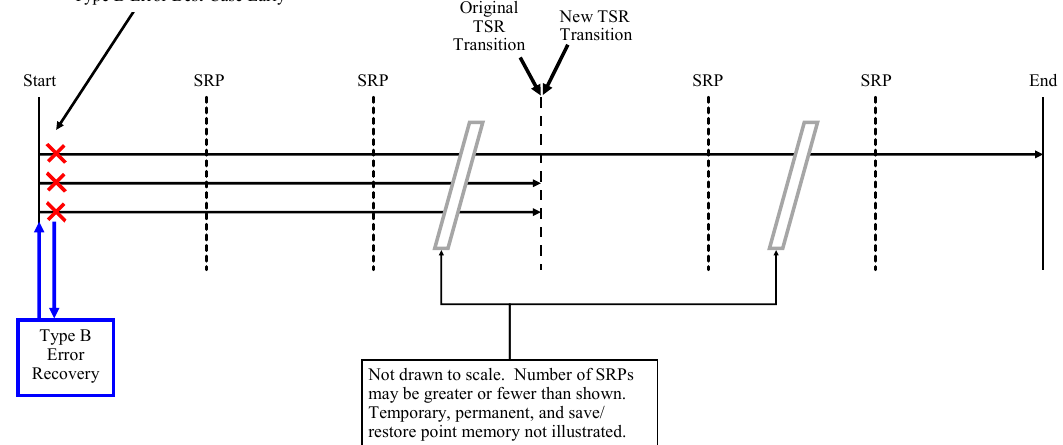
Figure A9. AHR MIPS TMR Type B Best-Case Early error timing diagram.